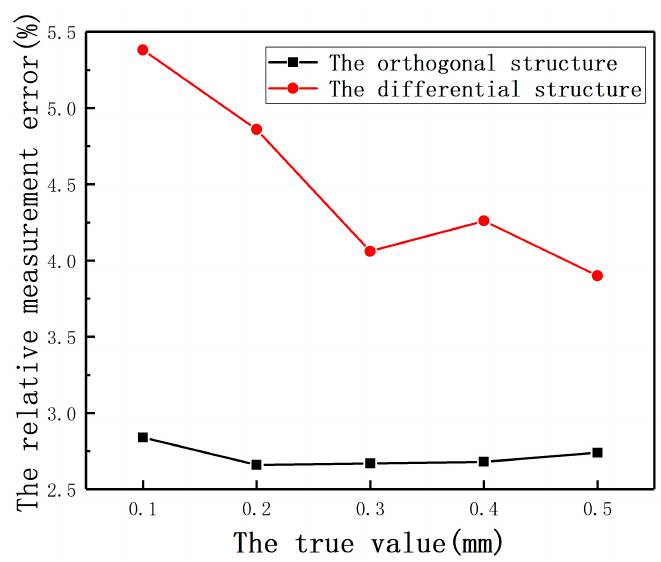
Figure 39. The relative measurement errors of the orthogonal structure and the differential structure.